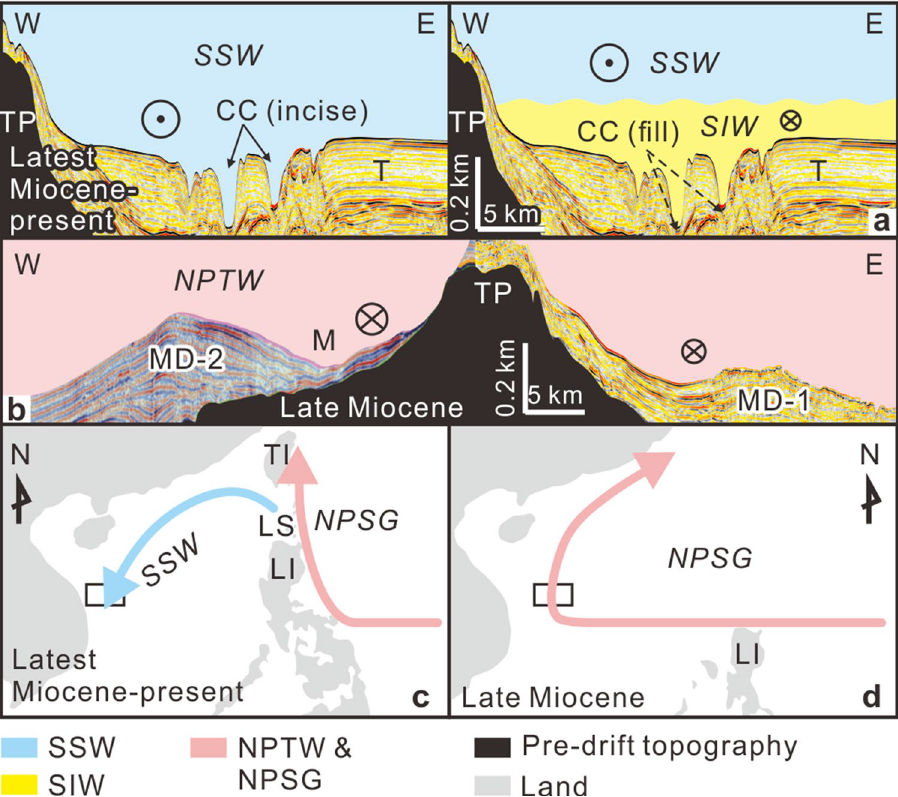
Figure 4. Sketches for the terrace and the contourite depositional systems for SU2 (a) and SU1 (b) formation under South China Sea circulation. Reconstruction of circulation from latest Miocene to present (c) and in late Miocene (d) . In panels (a,b) , current direction is indicated by the symbols: circled times = Northward flow and circled dot = Southward flow. Topography data source in (c) is ETOPO1 (https ://doi.org/10.7289/V5C82 76M, https ://ngdc.noaa.gov/mgg/globa l/globa l.html). Topography in (d) is modified from Hall, 2012 4 . Abbreviations for water masses given in text. Abbreviations for sedimentary features referenced to Fig. 2. Seismic images in (a,b) were generated using GeoFrame software (version 4.5, http://slb-sis.com.cn/produ cts-servi ces/GeoFr ame. aspx). All maps were designed using CorelDraw Graphics Suite X8 (https ://www.corel